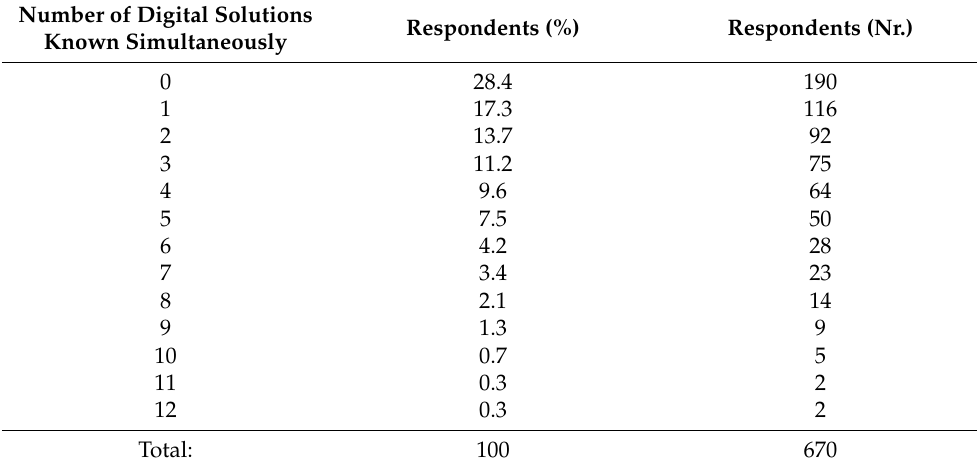
Table 8. Statistical distribution of the number of digital solutions known. Number of Digital